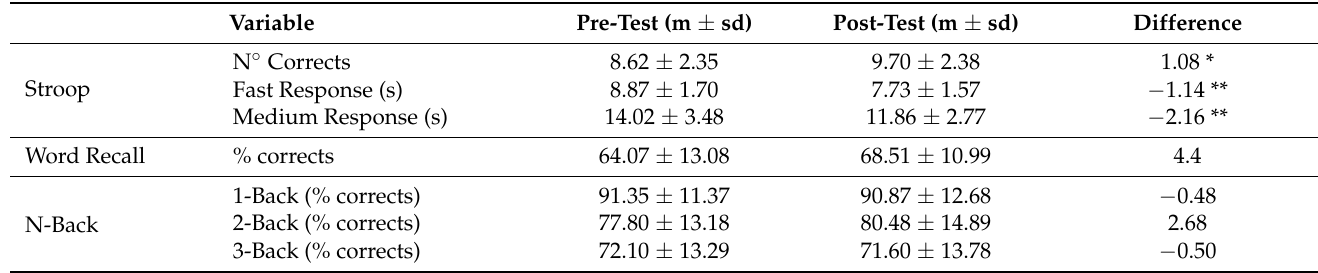
Table 4. HIFT Group. Descriptives of pre-test, post-test and differences.